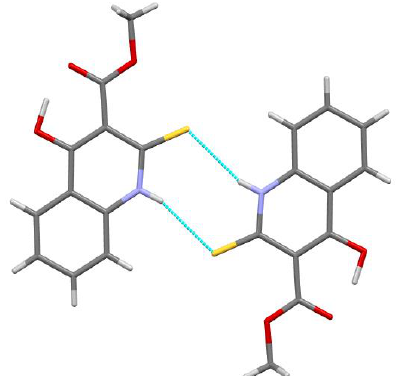
Figure1. Molecularstructureofcompound 13 accordingtoX-raydi ff ractiondata. Thermaldisplacement Figure 1. Molecular structure of compound 13 according to X-ray diffraction data. Thermal ellipsoids are shown at the 50% probability level. displacement ellipsoids are shown at the 50% probability level.